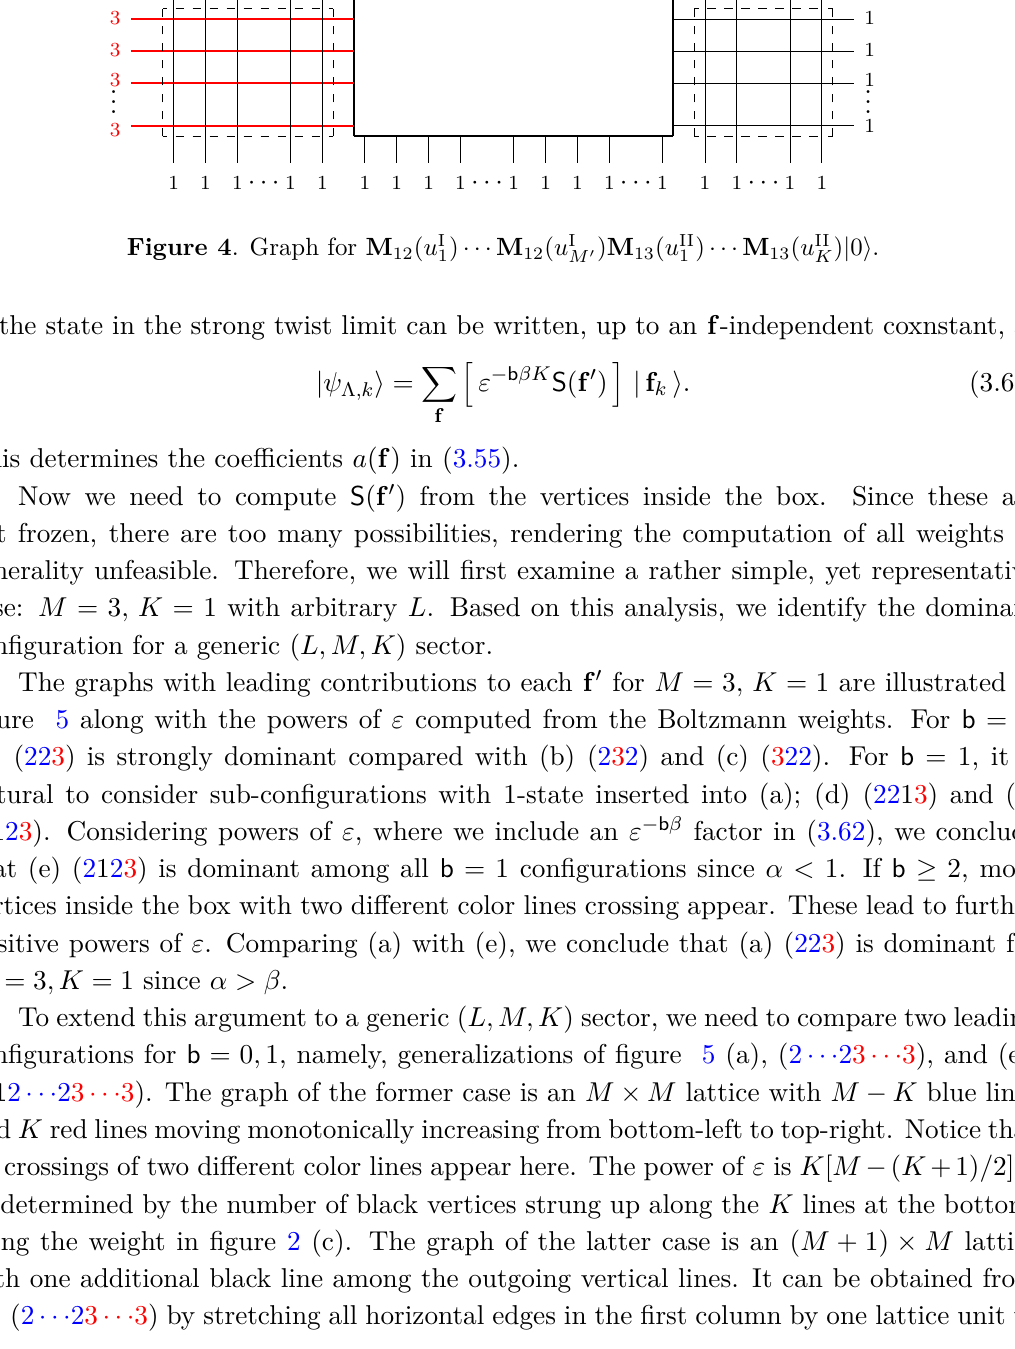
Figure 4 . Graph for M 12 ( u I